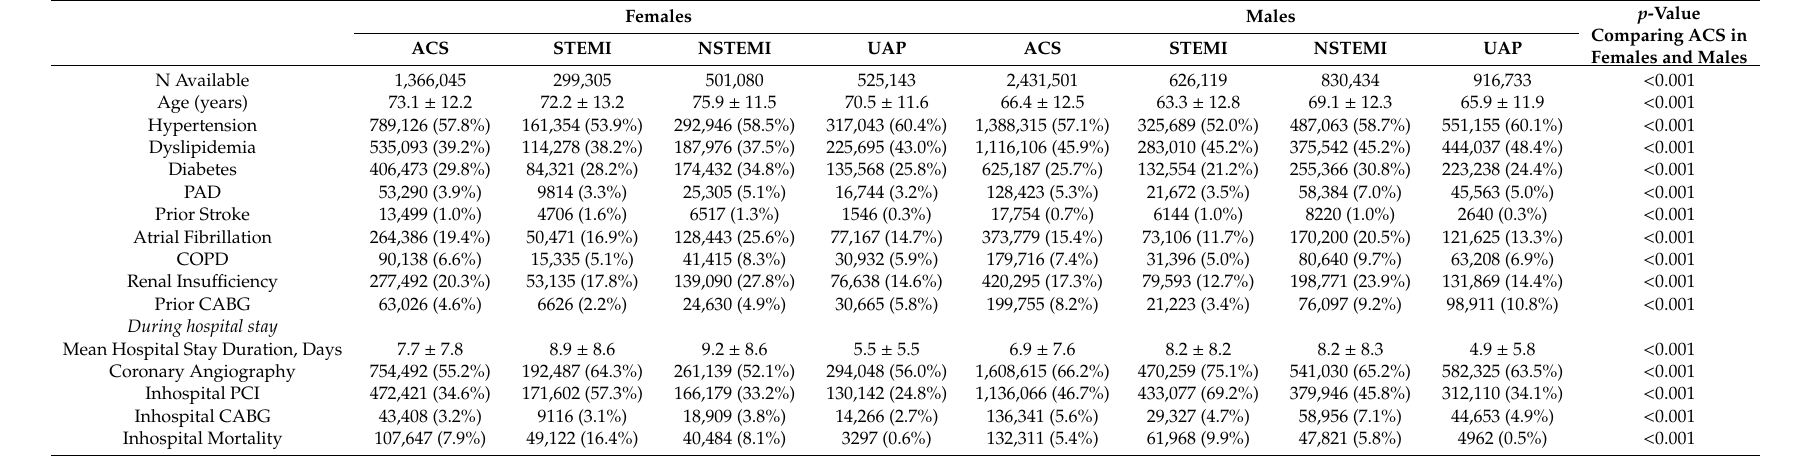
Table 1. Characteristics of patients with acute coronary syndrome (ACS), and subgroups of unstable angina pectoris (UAP), ST-elevation myocardial infarction (STEMI), and non-ST-elevation myocardial infarction (NSTEMI) in Germany from 2005 to 2015, separated by sex. PAD, peripheral artery disease; COPD, chronic obstructive pulmonary disease; CABG, coronary-artery bypass grafting; PCI, percutaneous coronary intervention. Females